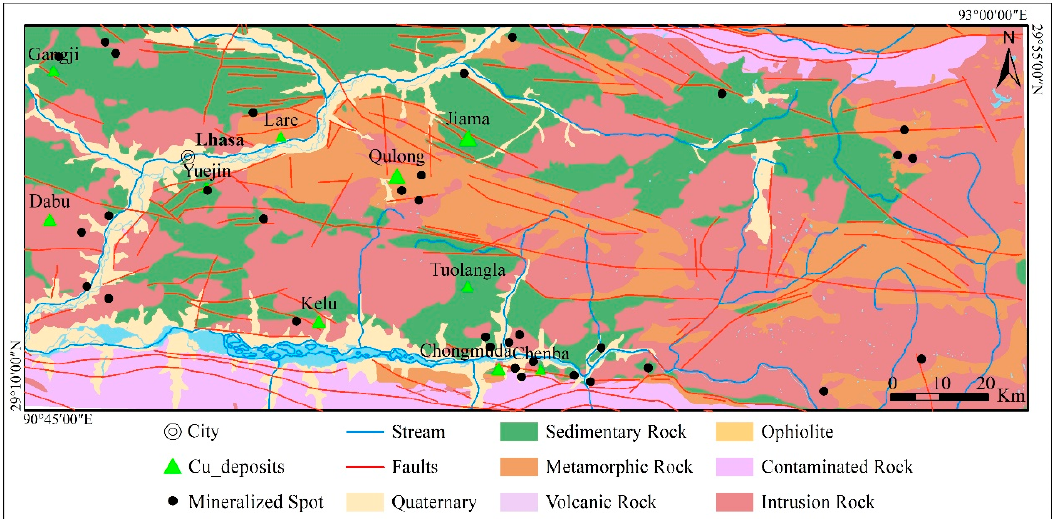
Figure 1. Simplified geological map of the study area.